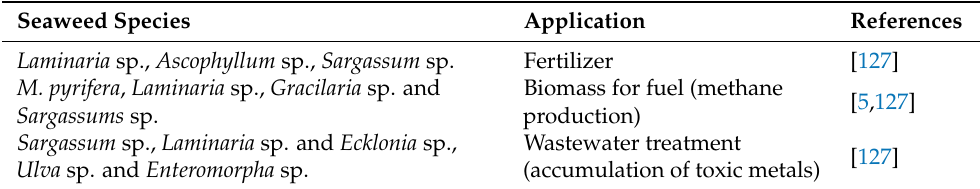
Table 5. Other applications of